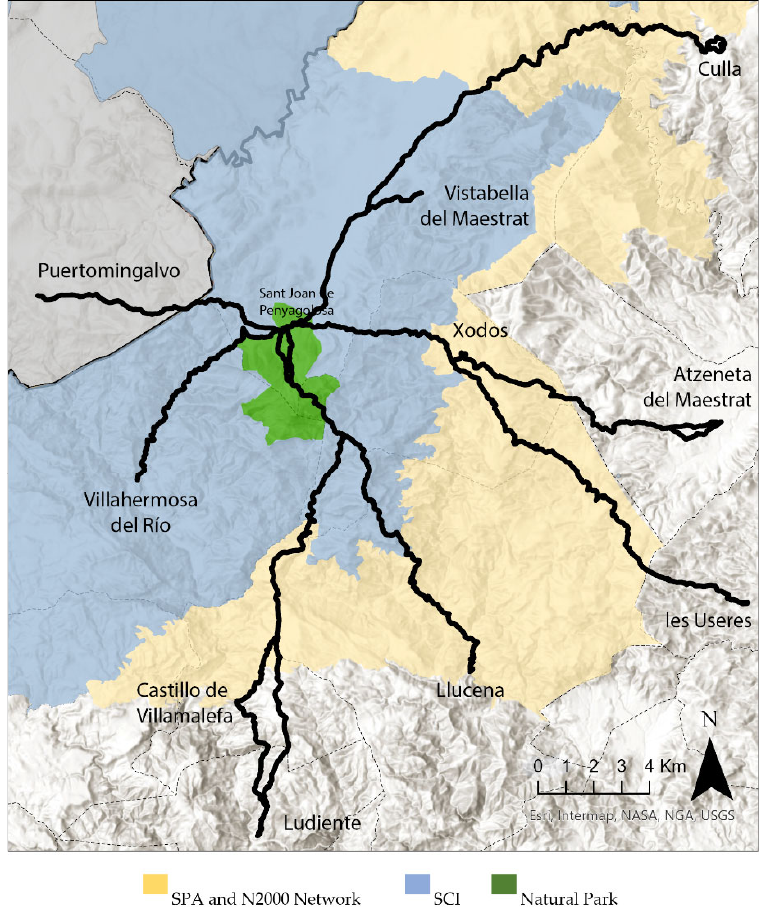
Figure 4. Distribution of areas protected by environmental and biodiversity legislation. Source: au ‐ thors.